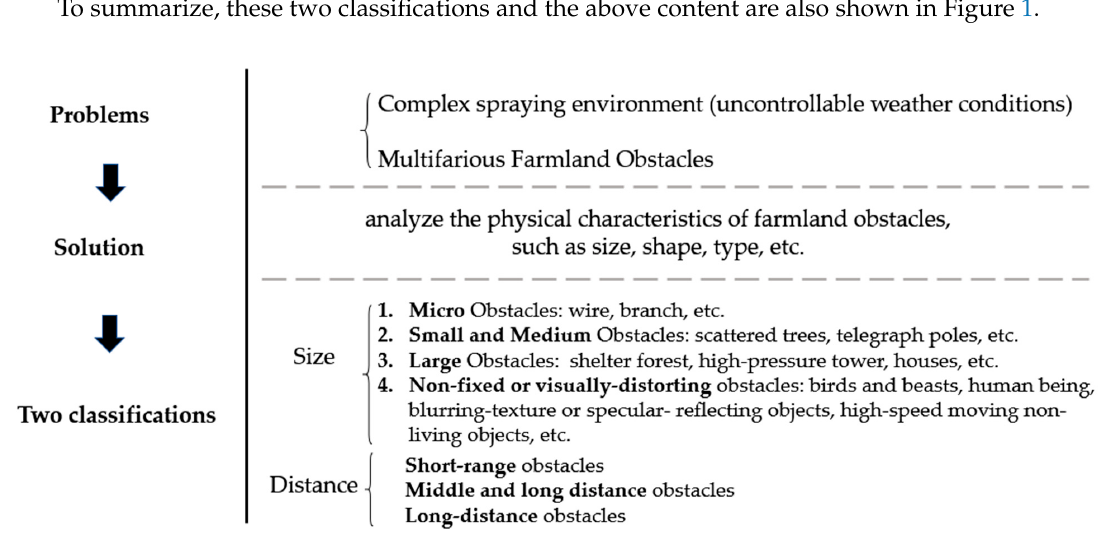
Figure 1. Analysis summary of farmland obstacles.